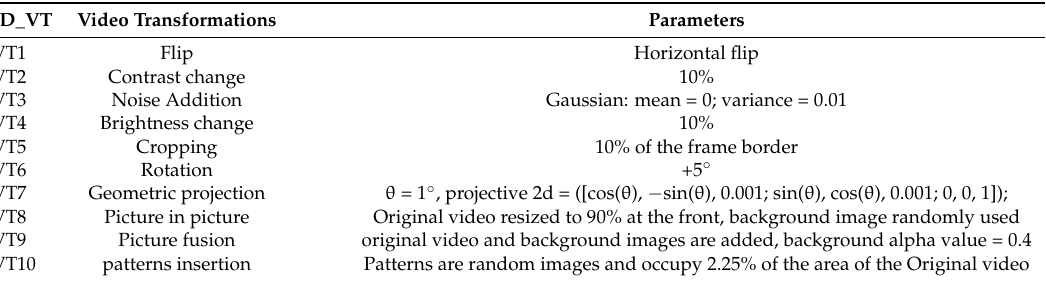
Table 18. Examples of common video transformations.